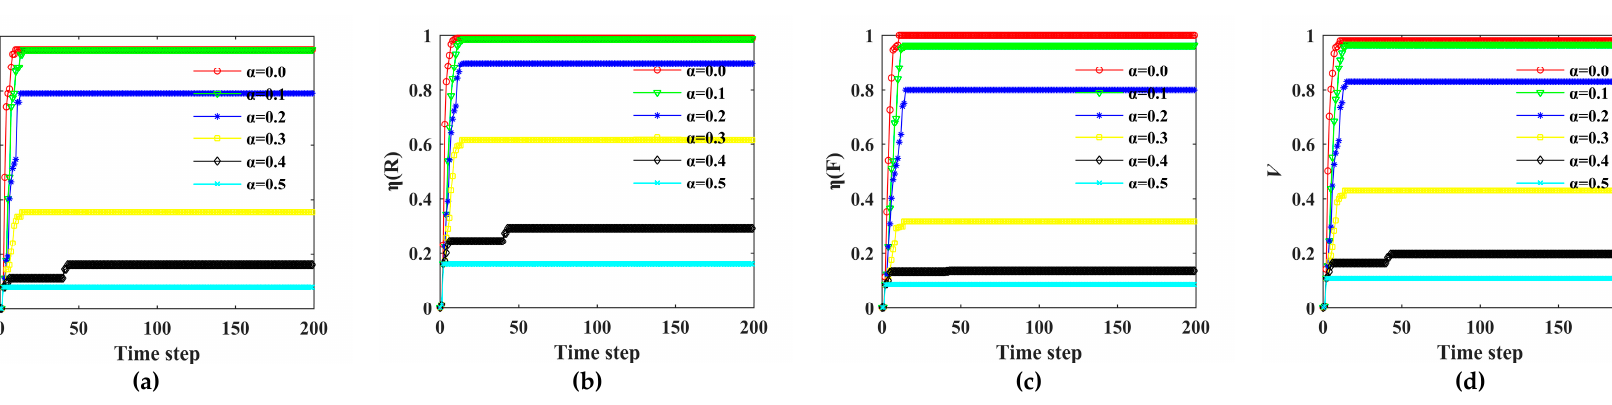
Figure 9. Cascading failures of Bus–Metro CBN under different capacity tolerances. ( a – c ) show the loss ratio of node scale in the maximum connected subgraph, the network efficiency and the passenger flow with time under different capacity tolerances, respectively. ( d ) shows the change of network vulnerability with time under different capacity tolerances. Note: In these scenarios, s = 1.0, ε 1 = 0.2, ε 2 = 0.2, λ 1 = λ 2 = λ 3 = 1 3